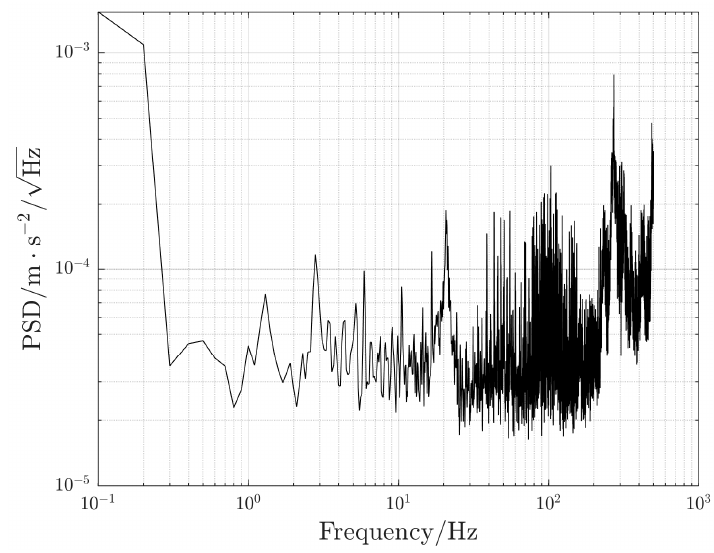
Figure 3. Vibration acceleration power spectrum density at the test place.